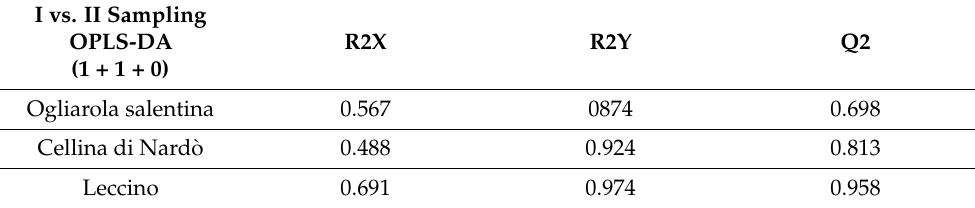
Table 2. Statistical parameters of supervised OPLS-DA models for first (I) and second (II) sampling periods in the naturally infected Leccino, Ogliarola salentina and Cellina di Nard ò cultivars. R2X and R2Y indicate the fraction of variance of the X and Y matrix, respectively. Q2 is a goodness of prediction parameter representing the portion of variance in the data predictable by the